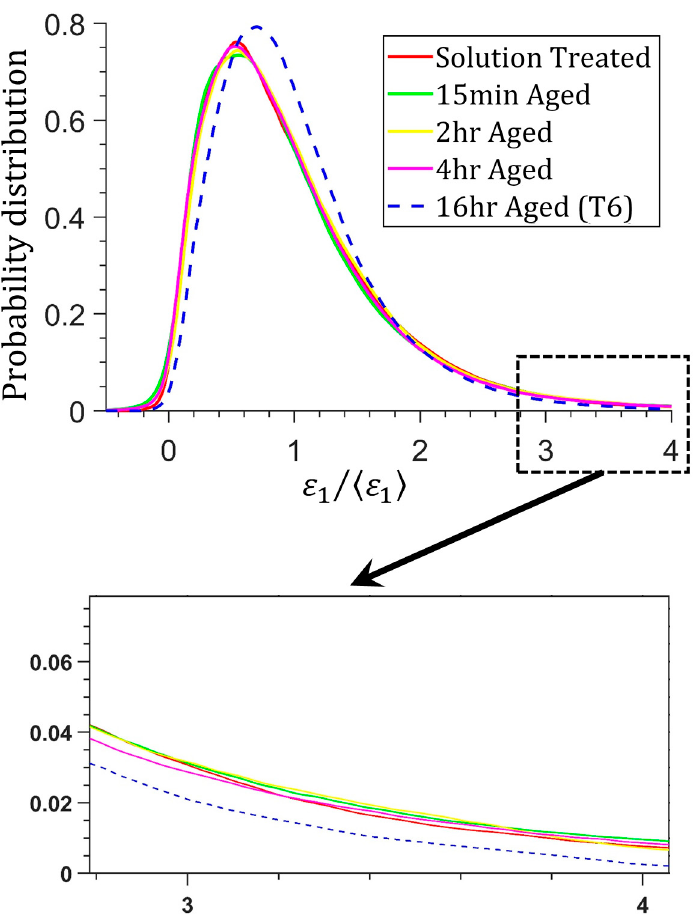
Figure 23. The probability distribution of normalized maximum principal strain ε 1 / (cid:104) ε 1 (cid:105) for WE43 Mg alloy subjected to different heat treatment conditions after solution treatment at the uniaxial tensile strain of ε = − 3.23% along the rolling direction (After Ganesan et al. [8]). They further investigated the effect of heat treatment using the CPFE simulation.